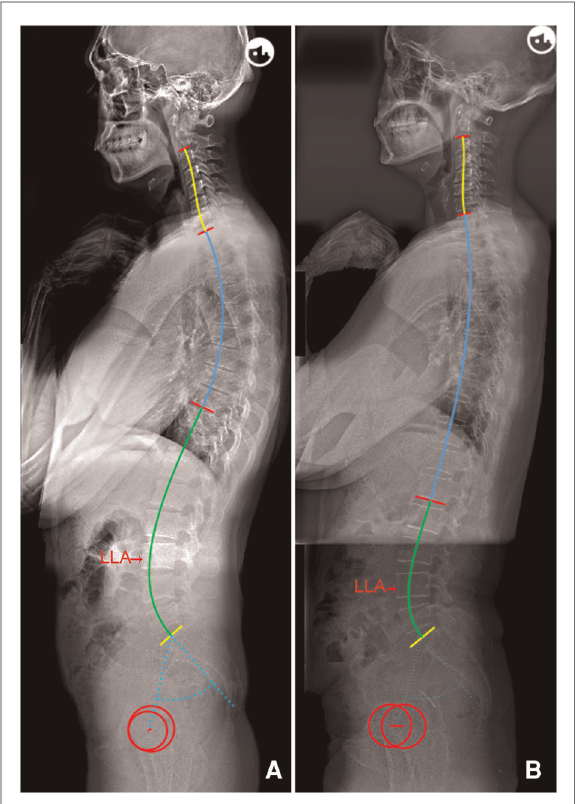
FIGURE 4 ( A ) Male, 29 years old, PI=54.4°, IP=9; LLA=15, LASO=50.7 mm, LLL=42.2°, ULL=24.8°, and LL=67.0°. ( B ) Female, 51 years old, with a similar PI (55.0°) to a, but a lower IP (13); LLA=16, LASO= 46.7 mm, LLL=39.5°, ULL=15.7°, and LL=55.2°. PI, pelvic incidence; IP, in fl ection point; LLA, apex of lumbar lordosis; LASO, the horizontal offset between the plumb line of the lumbar apex and that of the posterosuperior corner of S1; LLL, lower lumbar lordosis; ULL, upper lumbar lordosis; LL, lumbar lordosis.